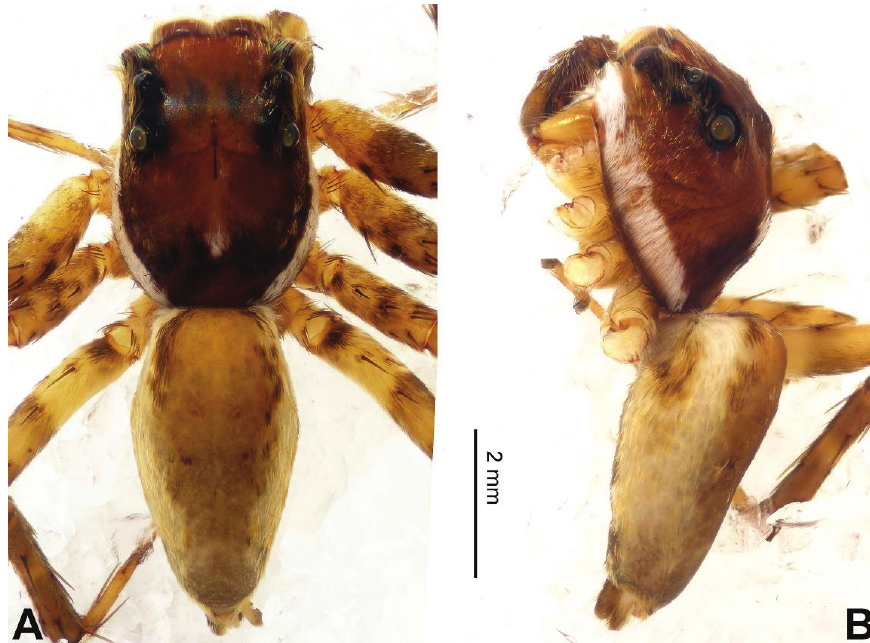
Figure 25. Habitus of Gelotia zhengi sp. n., male holotype. A dorsal B lateral. Genus Icius Simon, 1876 Icius bamboo Cao & Li, sp.